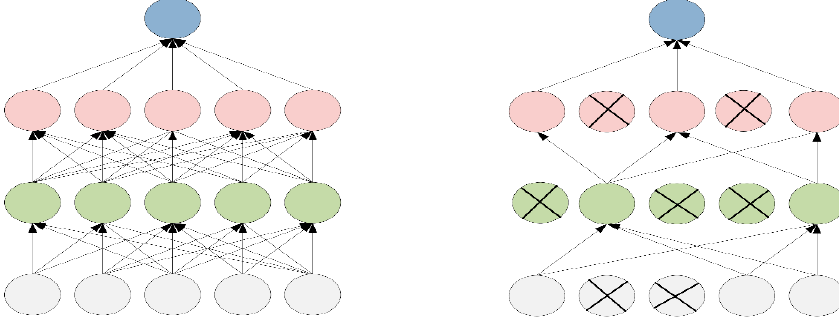
Figure 4. Fully connected layers (FC) before and after applying dropout.